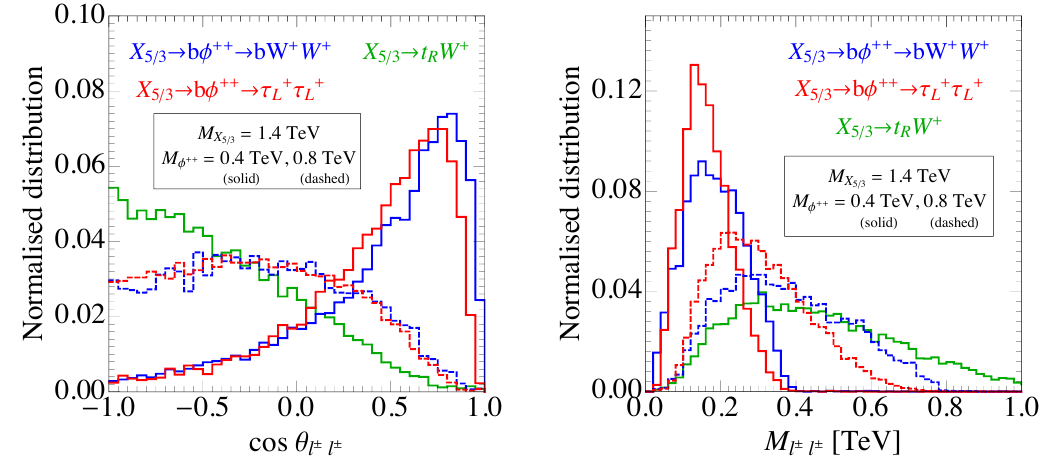
Figure 7 . Distribution of the relative azimuthal angle between the SSL pair (left) and invariant mass (right) for various X decays, assuming 100% branching ratio. All events pass the SSL cuts 5 = 3 detailed in section